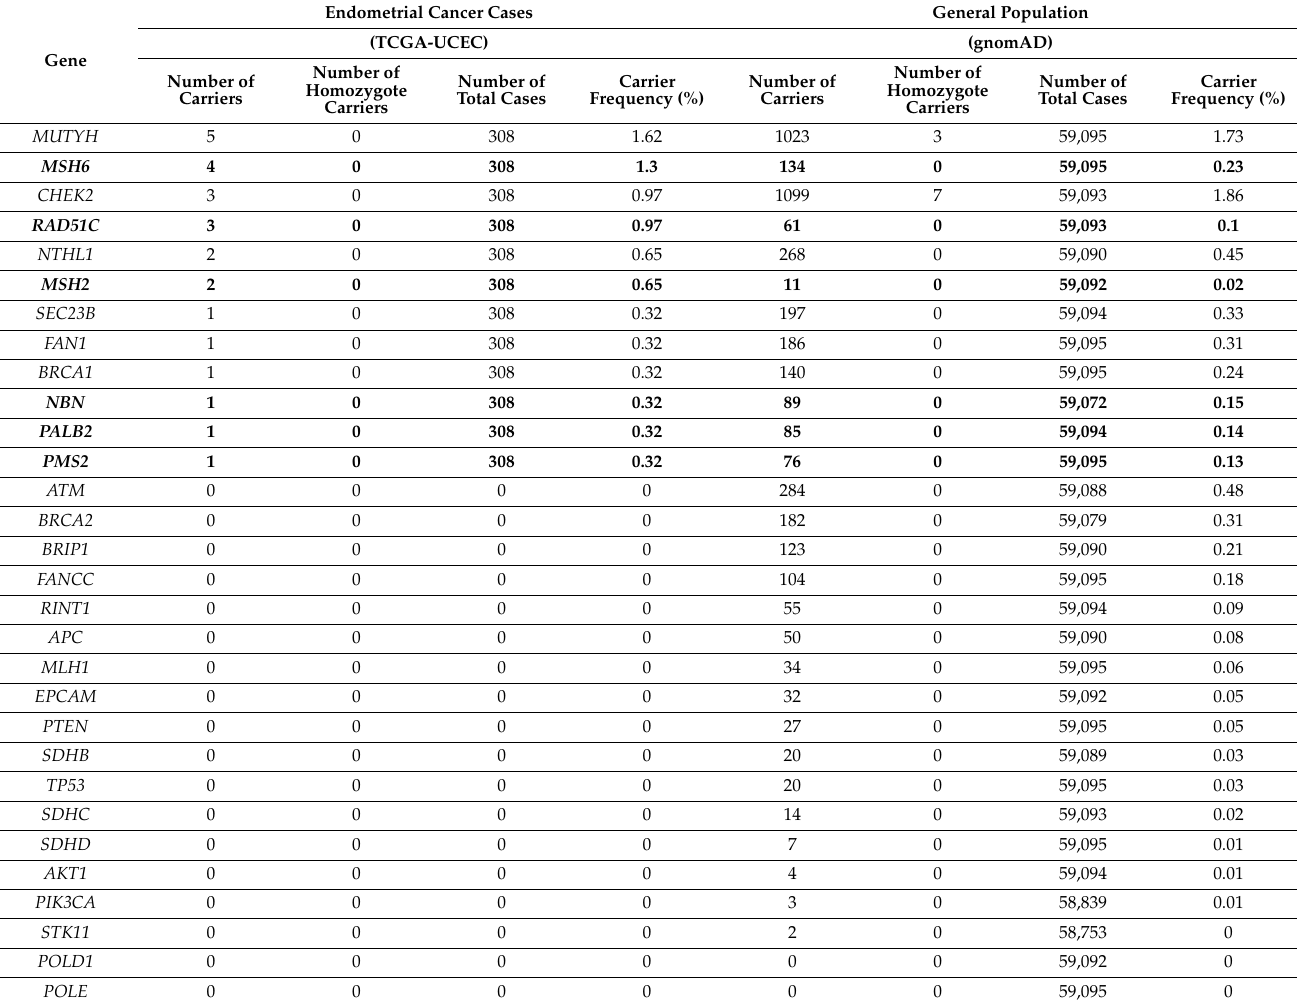
Table 1. Overall frequency of pathogenic and likely pathogenic variants in 30 known and candidate endometrial cancer (EC) risk genes in an EC sample set (TCGA-UCEC study) and the general population